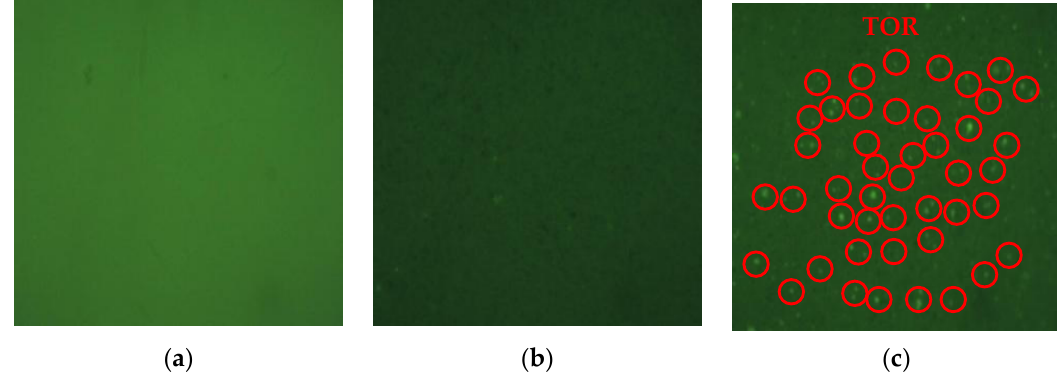
Figure 23. Fluorescent microscope images of asphalts. ( a ) JZ, ( b ) AR, and ( c ) TAR.